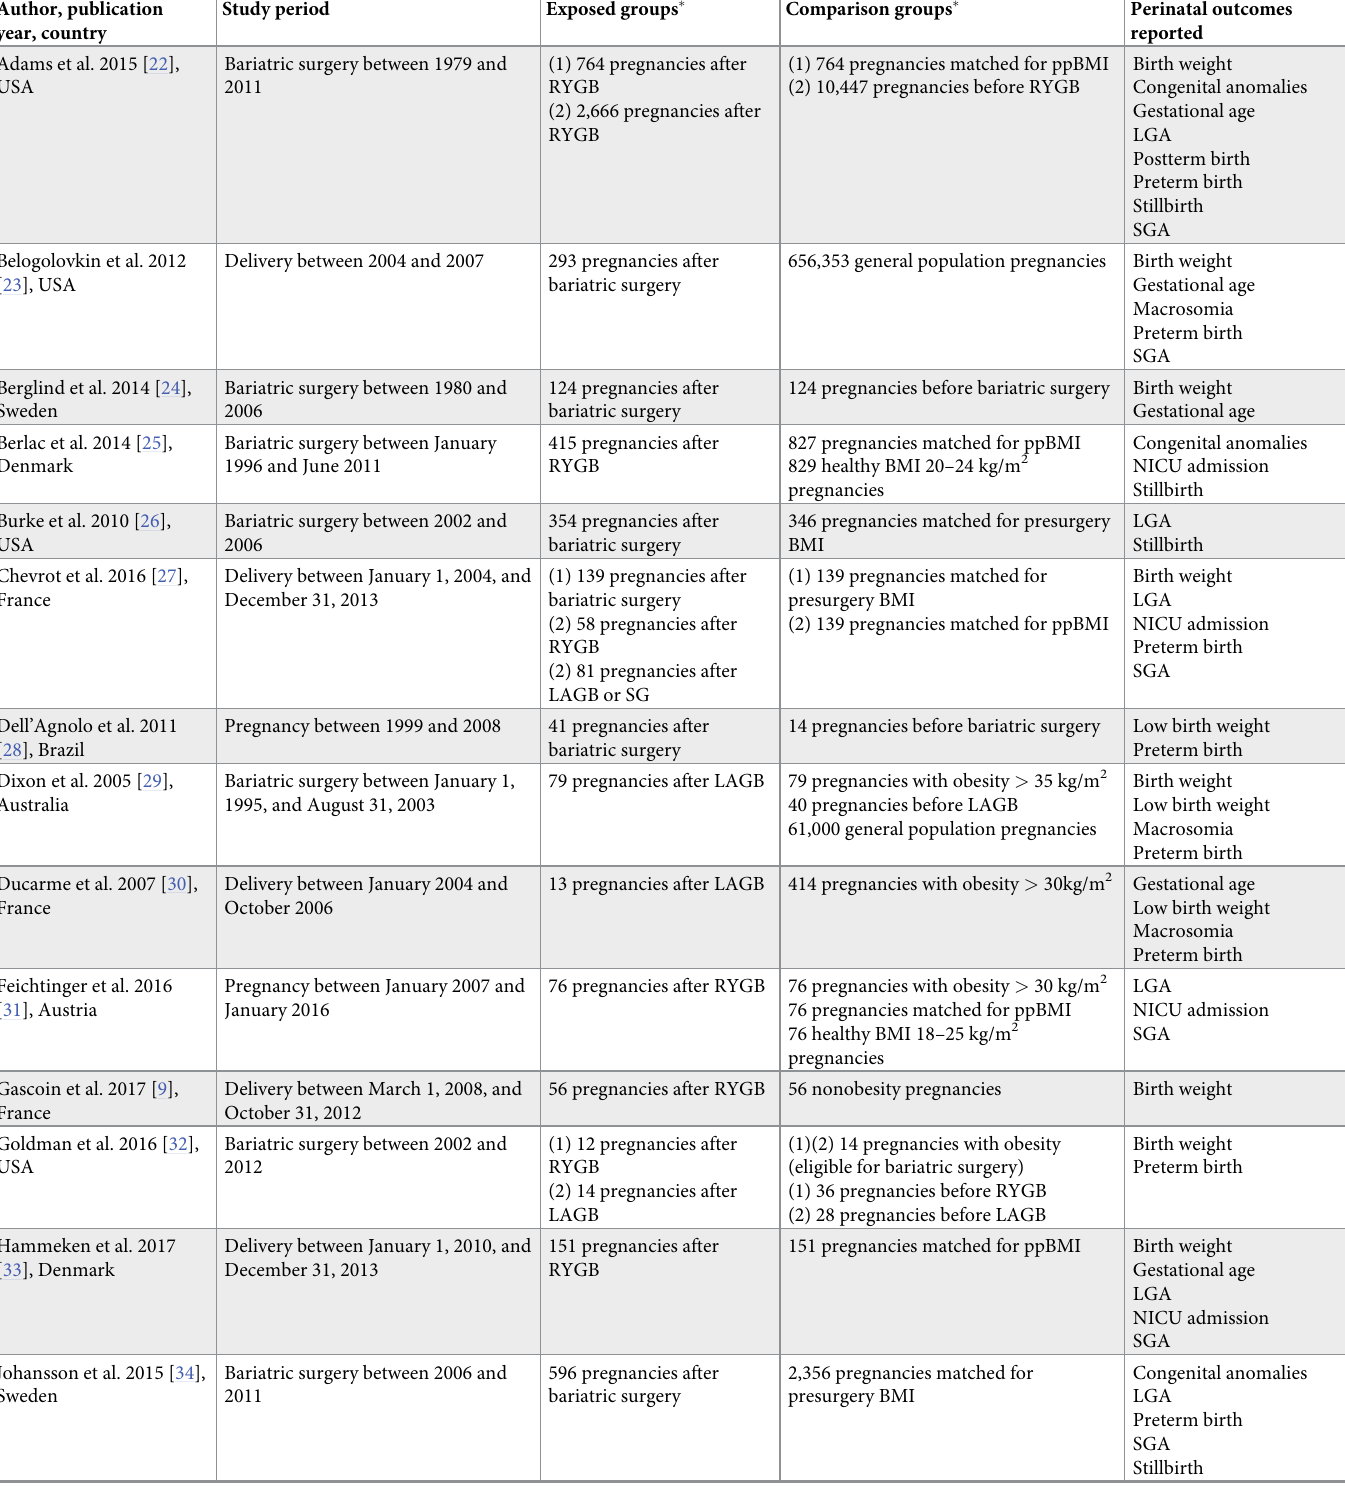
Table 1. Table of studies included in the systematic review and